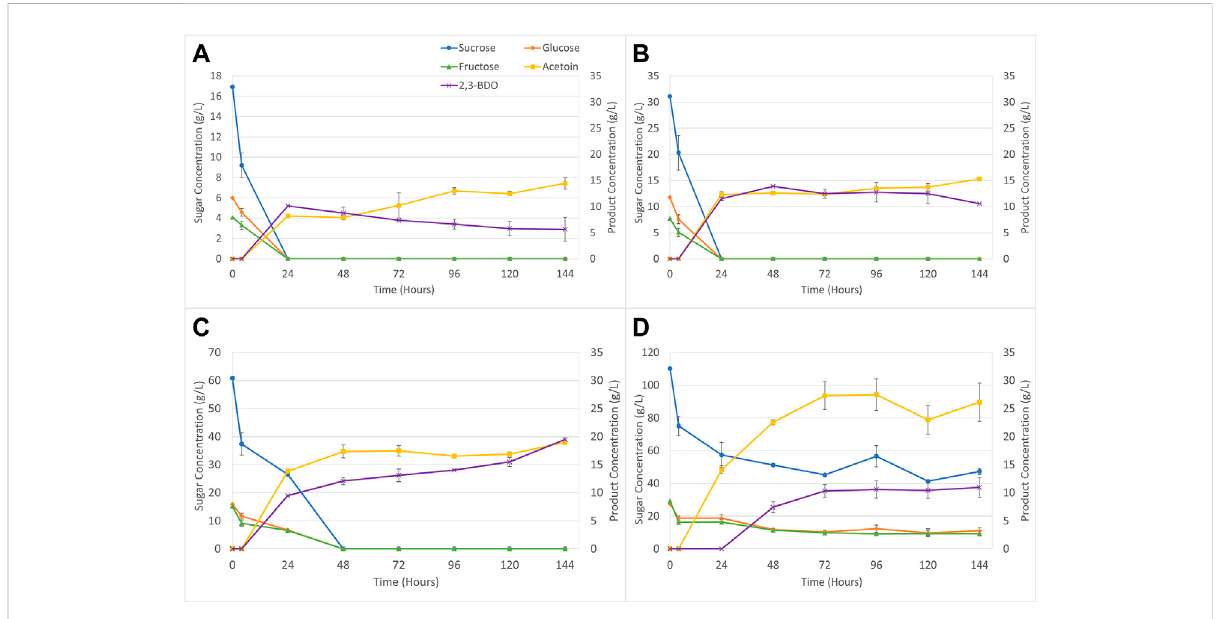
FIGURE 3 P. polymyxa sugar consumption and product generation during oxygen limited fermentation for (A) 12.5 g/L molasses loading, (B) 25 g/L molasses loading, (C) 50 g/L molasses loading, and (D) 100 g/L molasses loading.